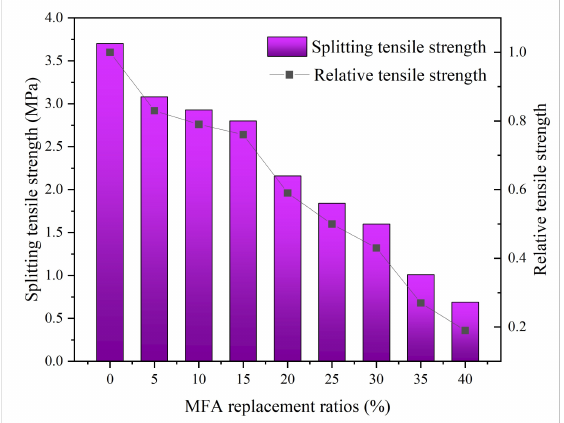
Figure 8. Splitting tensile strength versus MFA replacement